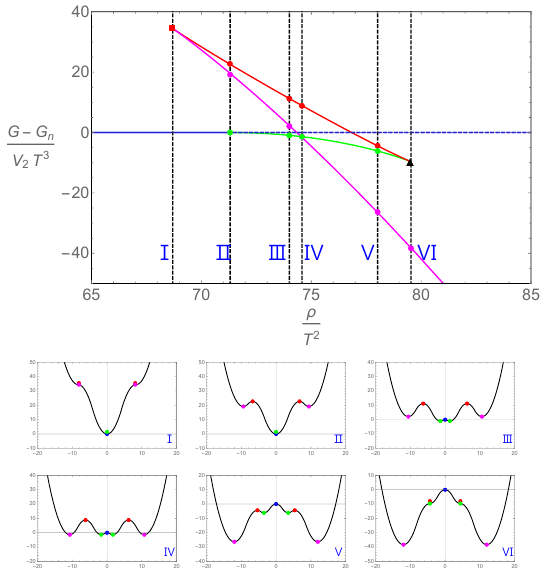
Figure 10 . The potential landscape the cave of wind phase transition. The shapes of the potential indicated with (I)-(VI) relate to the corresponding points in the top panel. Same colors are also